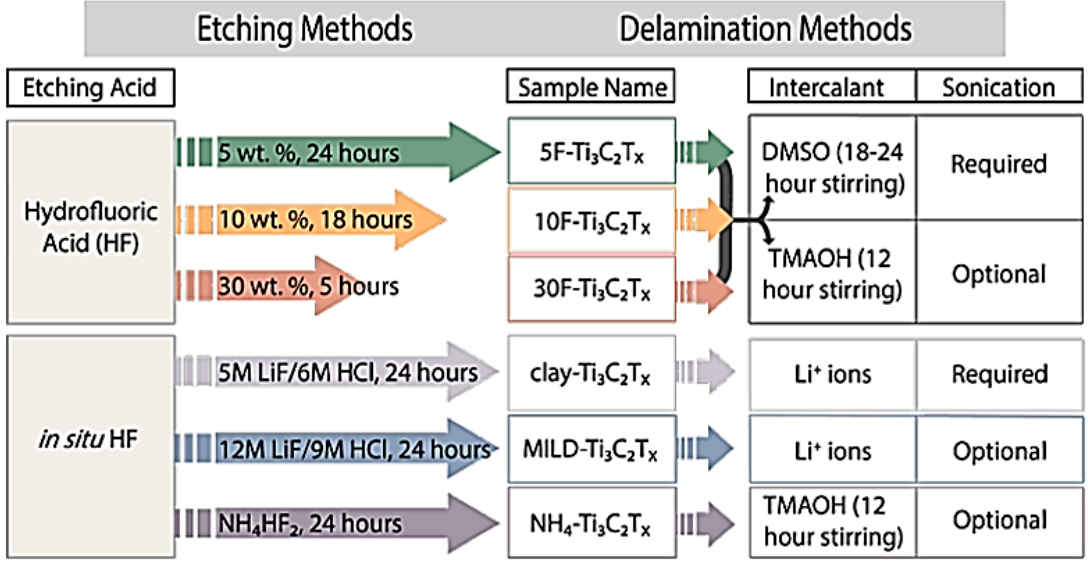
Figure 1. Preparation of Ti 3 C 2 T x using di ff erent synthesis routes (direct HF and in situ HF). Reproduced with permission from [36]. Copyright 2017